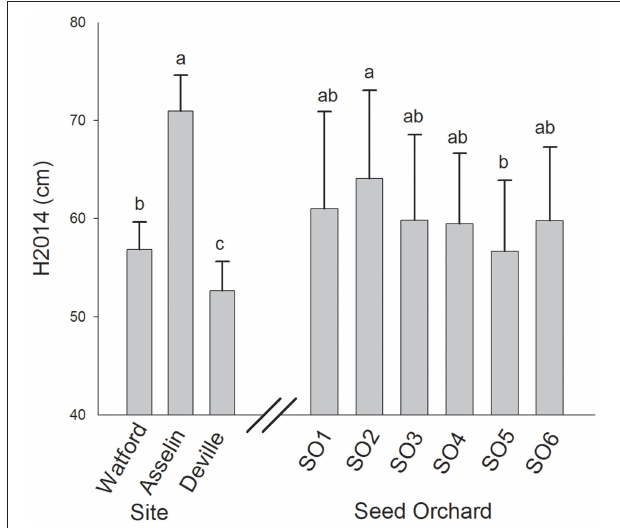
FIGURE 3 | Mean total height growth at the end of the second growing season (H2014) of white spruce seedlings from six seed orchards at three plantation sites. Means having the same letters are not significantly different at α = 0.05 . Values are the means ± SD.